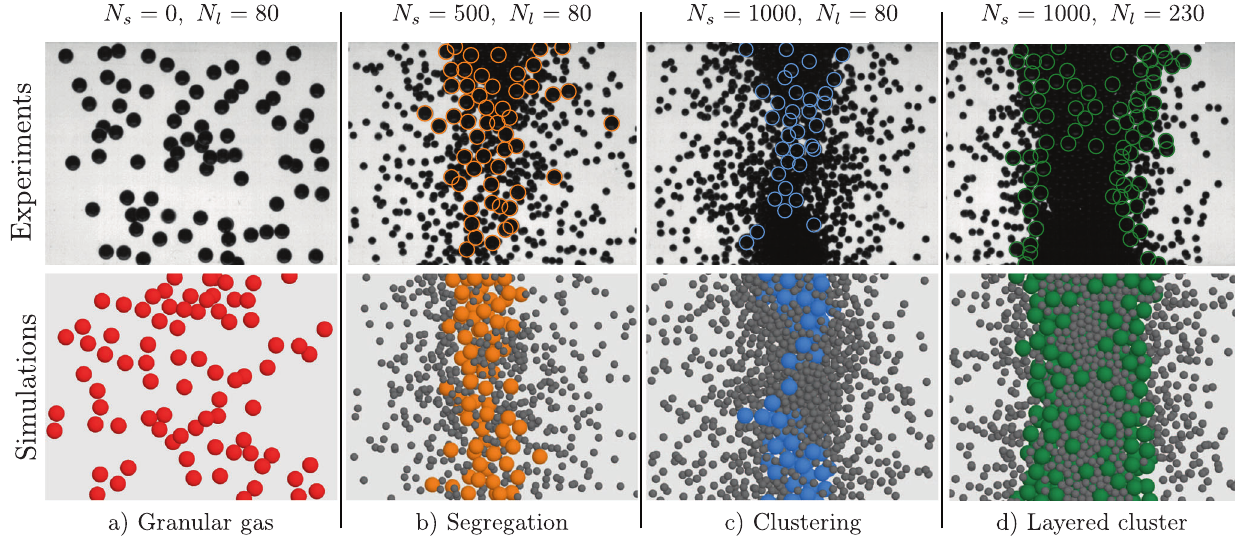
Fig. 1 Snapshots ( bottom view ) during experiments ( top ) and simulations ( bottom ). Large beads are highlighted with coloured circles. In the system with 80 ( a ) large beads, granular gas is observed. After the addition of 500 ( b ) and 1000 ( c ) small particles, segregation occurs and the large beads gather in the central bulk. Then 150 additional large grains ( d ) are injected and a complex pattern arises. The sinusoidal forcing is along the horizontal axis